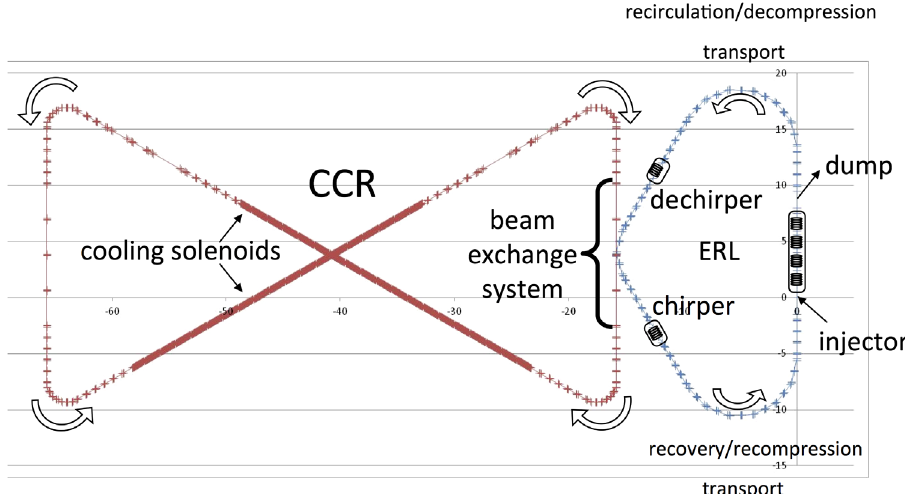
FIG. 1. Schematic layout of the early CCR design for the JLEIC